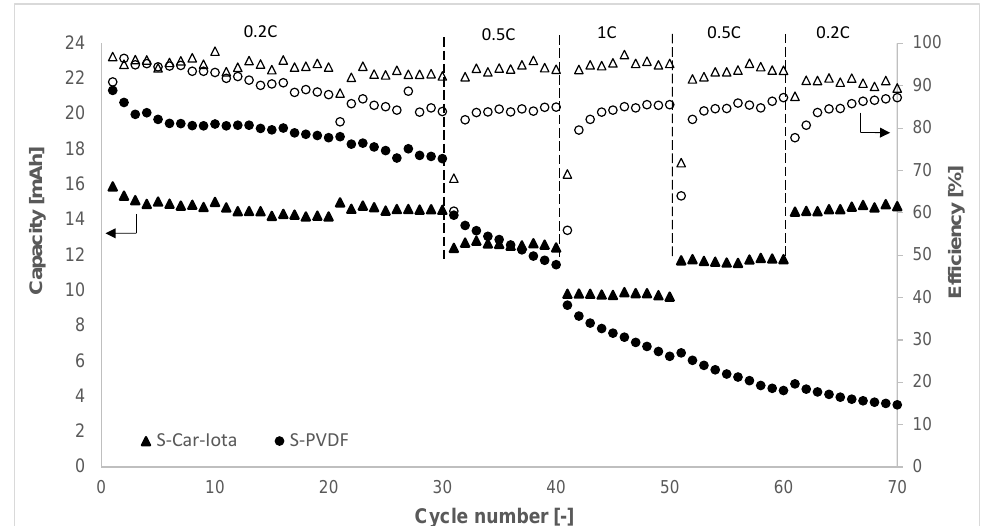
Figure 5. Galvanostatic cycling of the S-PVDF and S-Car-Iota pouch cells. A comparison of the discharge cycles of the S-PVDF and S-Car-Iota pouch cells is shown in Figure 6. It is evident that, during cycling, S-PVDF (Figure 6A) is losing the potential of the higher and lower discharge plateaus and the higher discharge plateau related to polysulfide shuttle decreases in connection with the active material losses. However, the S-Car-Iota pouch cell is very stable. The potentials of the higher and lower discharge plateaus stay the same, and capacity at the higher discharge plateau re- mains the same during the whole cycling. The electrode with the carrageenan iota binder can prevent polysulfide shuttle and compensate for the volumetric expansion of sulfur during cycling.